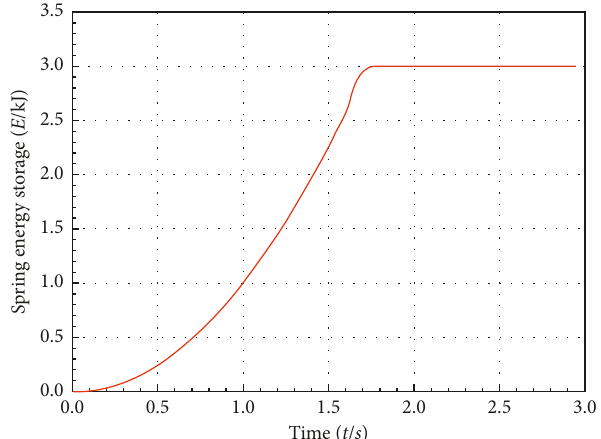
Figure 10: Cosimulation result of spring reaction from AMESim.